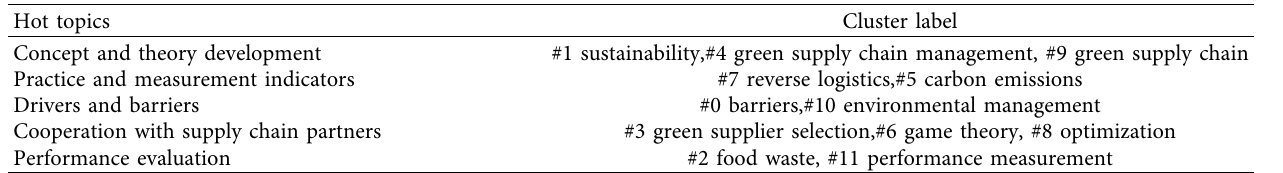
Table 5: Hot modules of Supply Chain Management